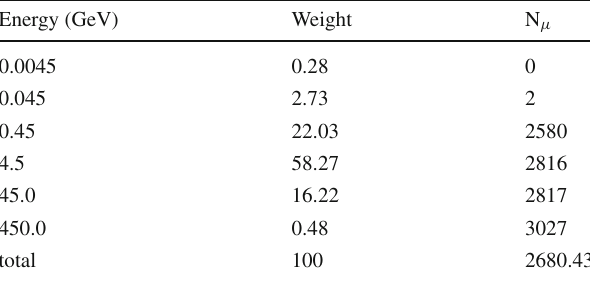
Table 2 Number of simulated muon triggers, N μ , for the NUCIFER experiment for different muon energies E. In total 10 4 muons were simulated for each energy. The weights are given within the logarithmic energy bin centered at the energy E with respect to the total flux. The total number of triggers is given by the weighted sum of the mono- energetic simulations